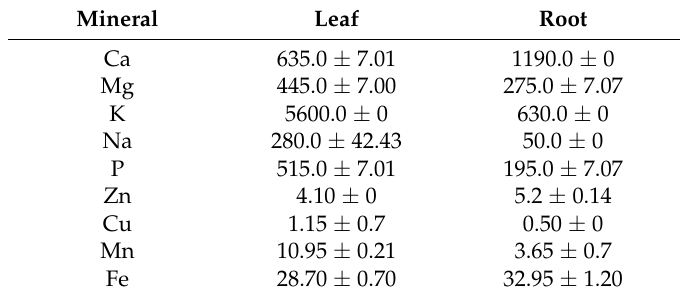
Table 1. Mineral composition of the leaf and root of Rumex crispus in mg/100g.